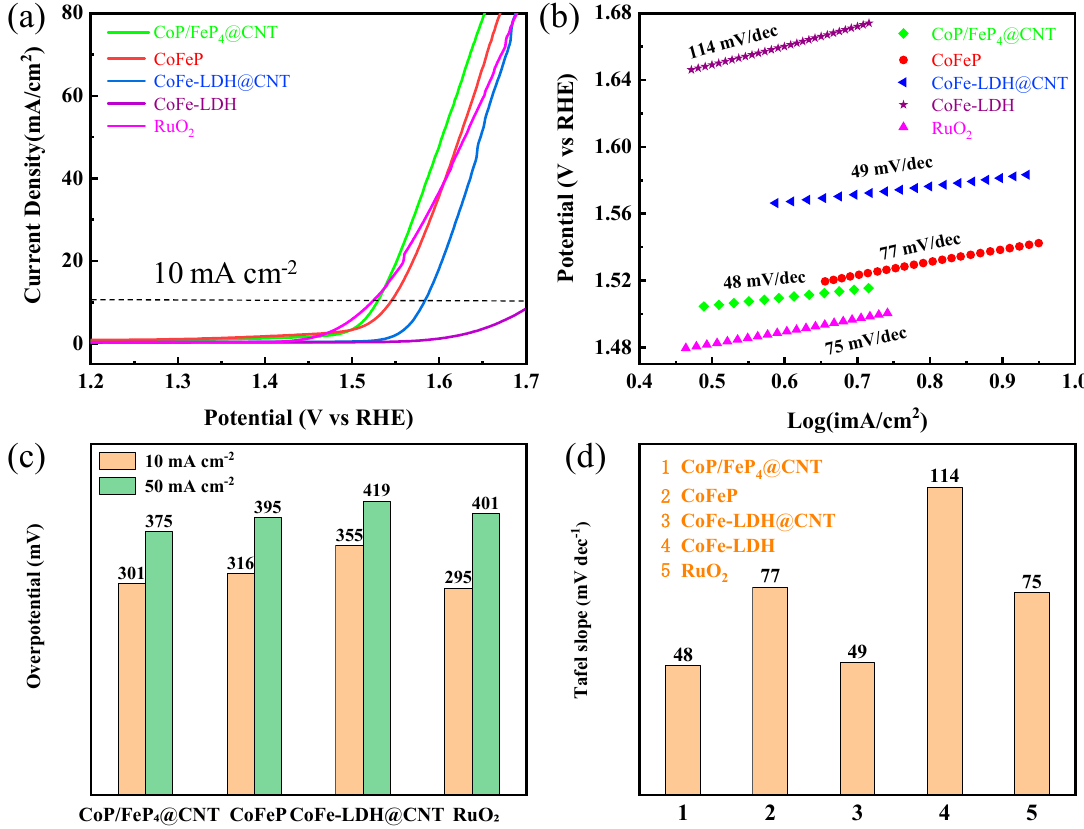
Figure 5. ( a ) LSV curves in 1 M KOH solution, ( b ) Tafel plots, ( c ) the potential of 10 mA cm − 2 and 50 mA cm − 2 , ( d ) the bar graph of the Tafel plots.